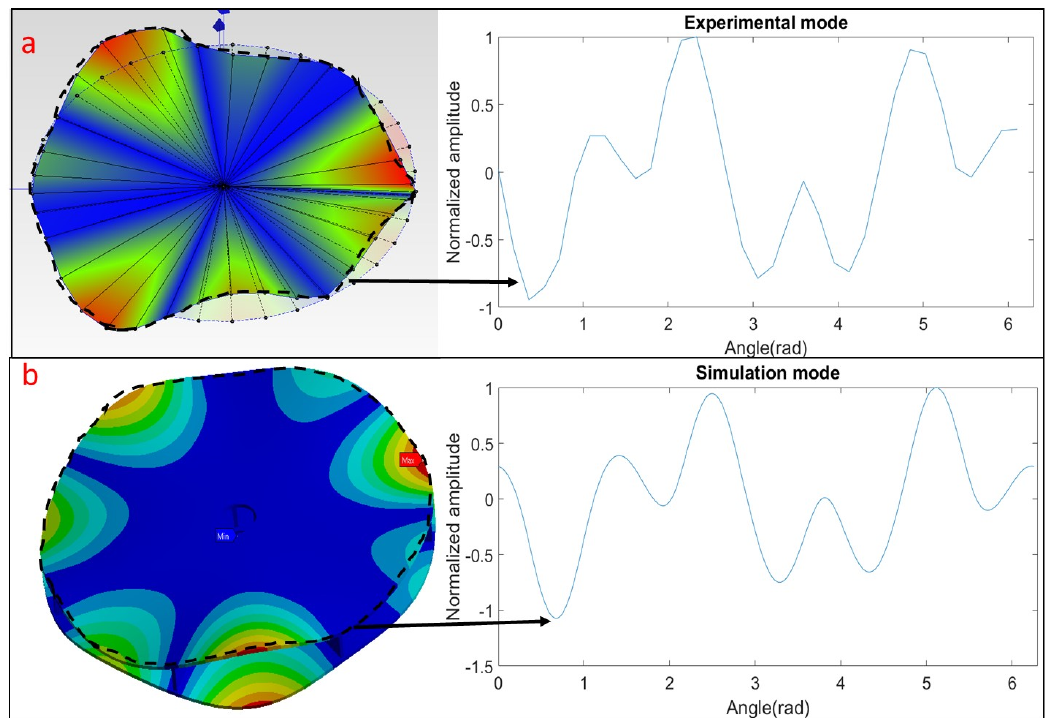
Figure 11. Analyzed diametrical modes. Experimental response of the structure measuring different positions of the bladed-disk with the LDV ( a ) and the PZT ( b ). Standing structure (not rotating).